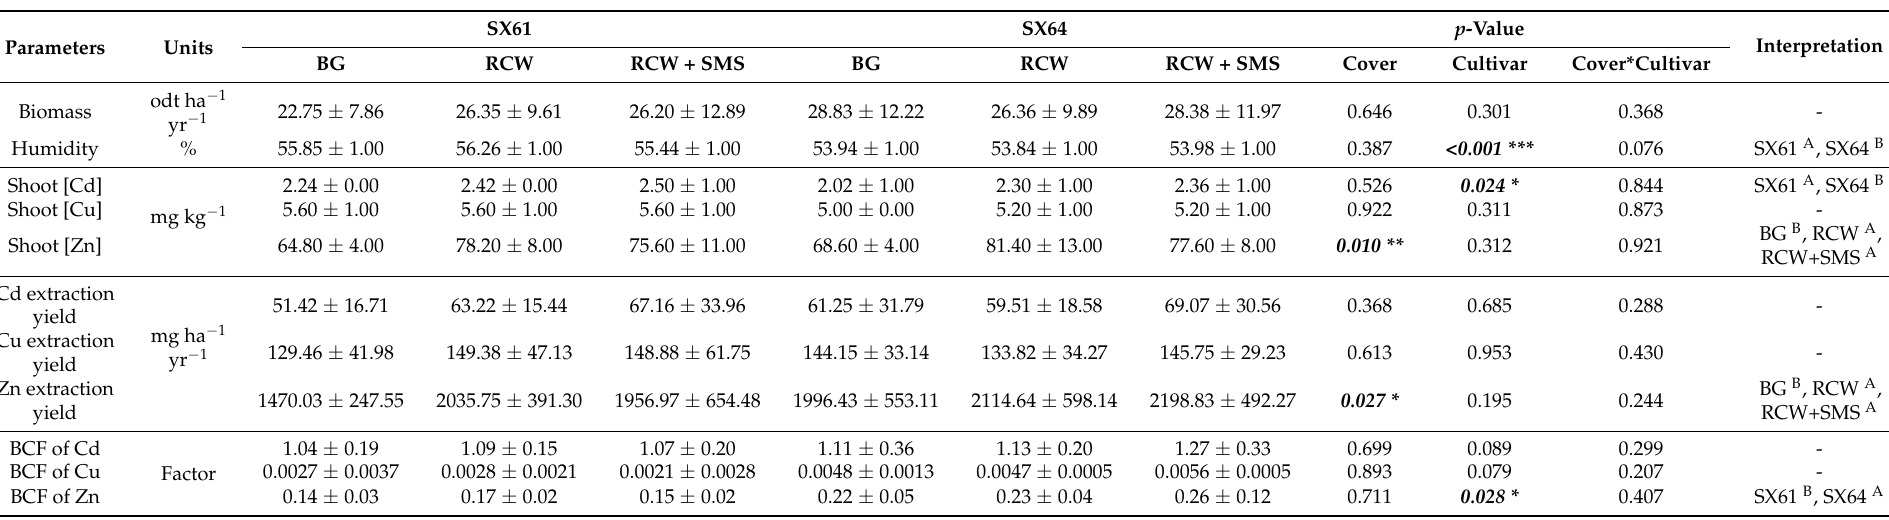
Table 5. Biomass parameters of willows after three